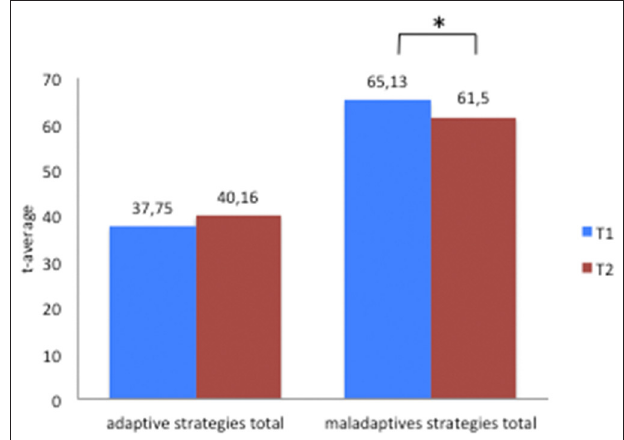
FIGURE 1 | FEEL-KJ-Adaptive and maladaptive scales-total. * symbol of significance.